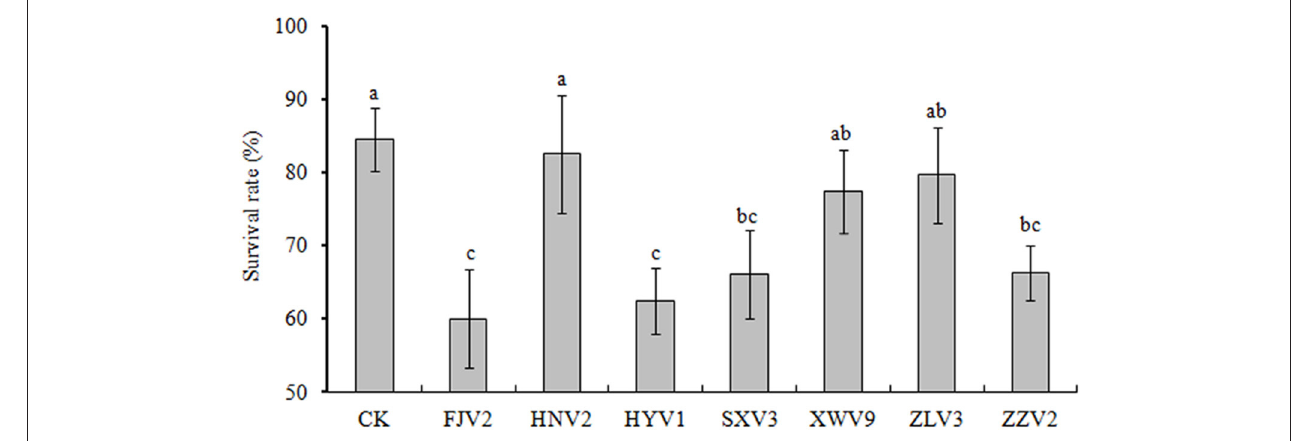
FIGURE 7 | The percentages of survival rate of L. vannamei postlarvae after treatment with the seven V. alginolyticus